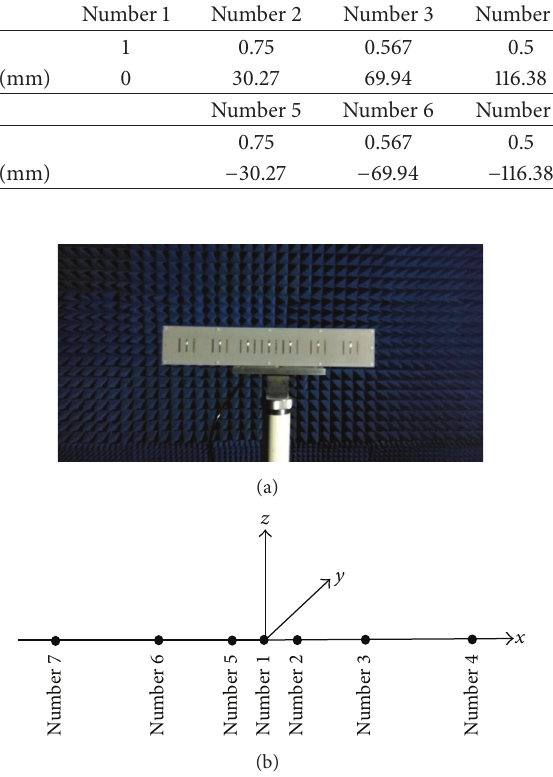
Figure5:Configurationanddistributionofthesymmetricweighted thinned array. (a) Prototype of the array. (b) Distribution.